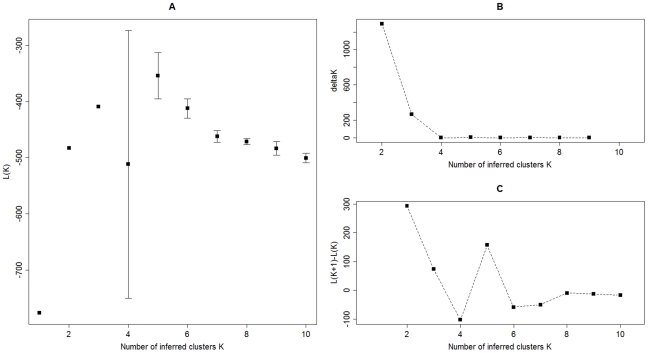
Determination of the optimal value of K (i.e. the optimal number of clusters in the dataset).A. Mean (± SD) of Ln P(D) over 10 STRUCTURE runs for successive K values ranging from 1 to 10, B. Variations of ΔK as calculated by Evanno and colleagues [34] and C. Variations of L(K+1)-L(K) as calculated by Garnier and colleagues [35] for successive K values.